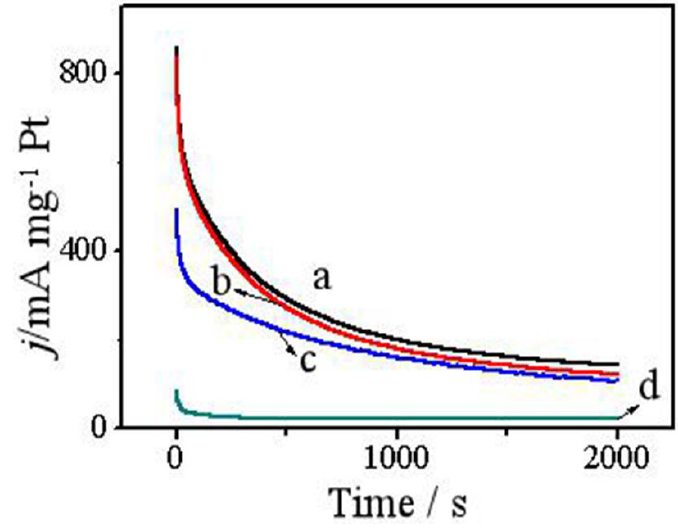
Figure 6. Chronoamperometric curves in 1.0 M CH 3 OH + 1.0 M NaOH: Pt-Bi (Bi 2 O 3 )/GNs (PVP) ( a ), 30% PtRu/C-JM ( b ), Pt/GNs (PVP) ( c ), and Pt-Bi (Bi 2 O 3 )/GNs ( d ), at 100 mV s − 1 . Pt-Bi (Bi 2 O 3 )/GNs (PVP) and Pt-Bi (Bi 2 O 3 )/GNs were also investigated as potential